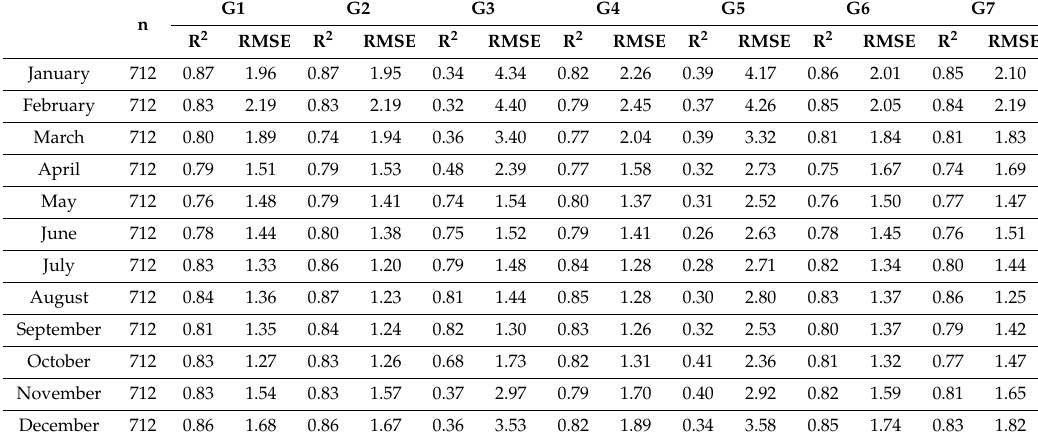
Table A2. PLS regression results. Summary statistics (R 2 and RMSE) for the monthly Ta prediction models, including six groups of